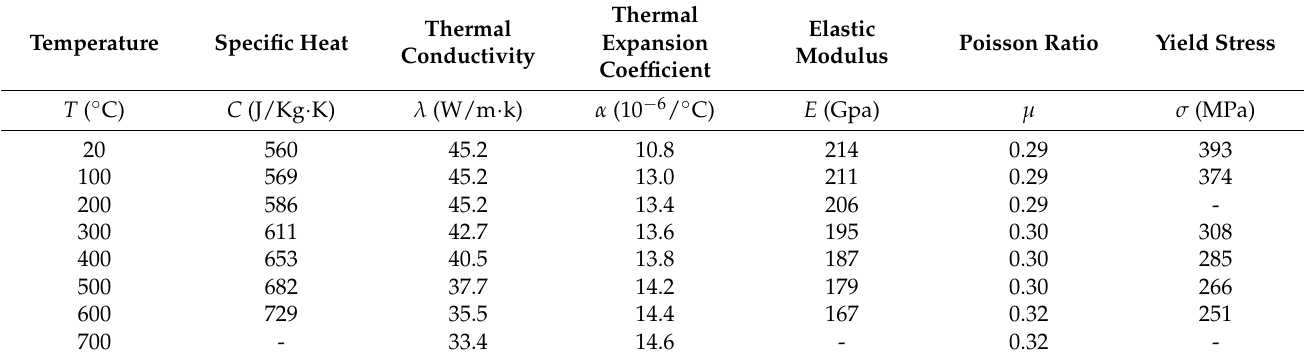
Table 3. Thermo-physical properties of 12Cr1MoV steel used in the finite element model.